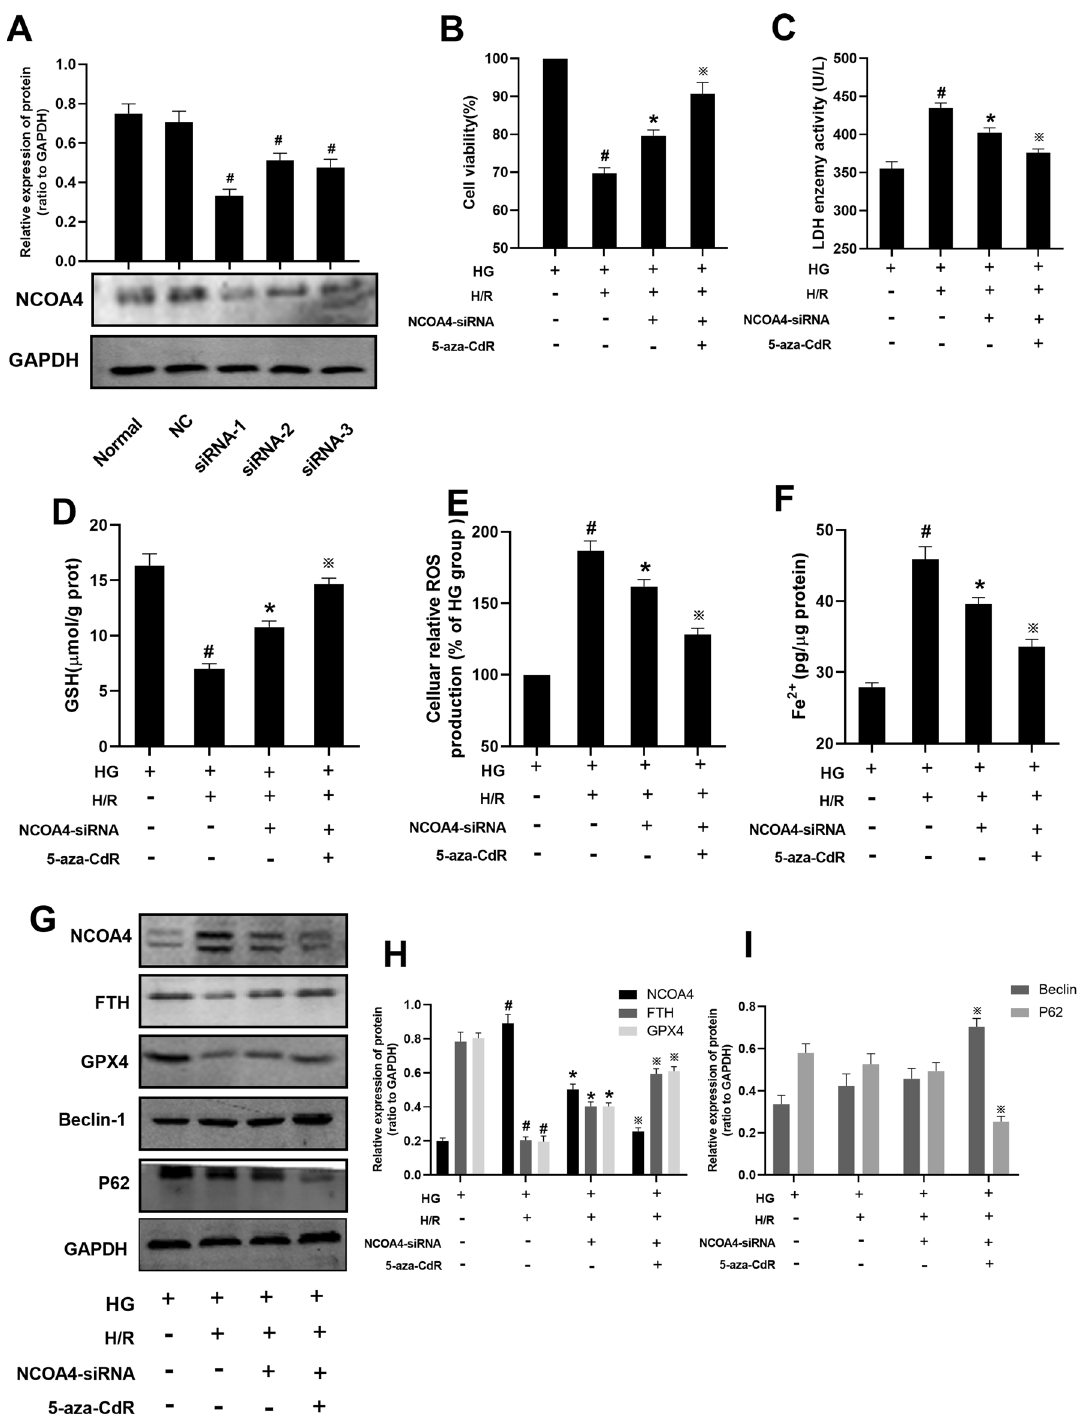
Fig. 8 Effect of DNMT-1 on the autophagy-ferroptosis axis of HH/R H9c2 cells through NCOA4. A The protein expression of NCOA4 was detected by western blotting. B Cell viability was detected by CCK-8. C – F LDH, Fe 2 + , GSH, cellular ROS production was detected. The protein expression of NCOA4, FTH, GPX4, Beclin-1, and p62 in H9c2 cells was detected by western blotting. Results are presented by means ± SD. n = 6 per group. # P < 0.05 compared with the HG group. * P < 0.05 compared with the HH/R group. ※ P < 0.05 compared with the HH/R + NCOA4- siRNA the level of DNA methylation. The promotion of DNA demethyla- tion may be a self-repair mechanism of the body [39]. Therefore, it is worth investigating whether inhibiting the activity of DNMT- 1 can alleviate DIR, which may provide a potential target for treatment.